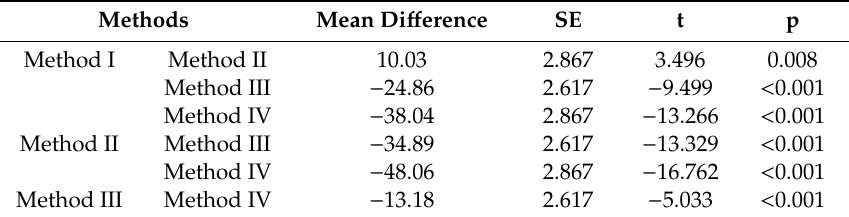
Table 2. Post hoc test—method